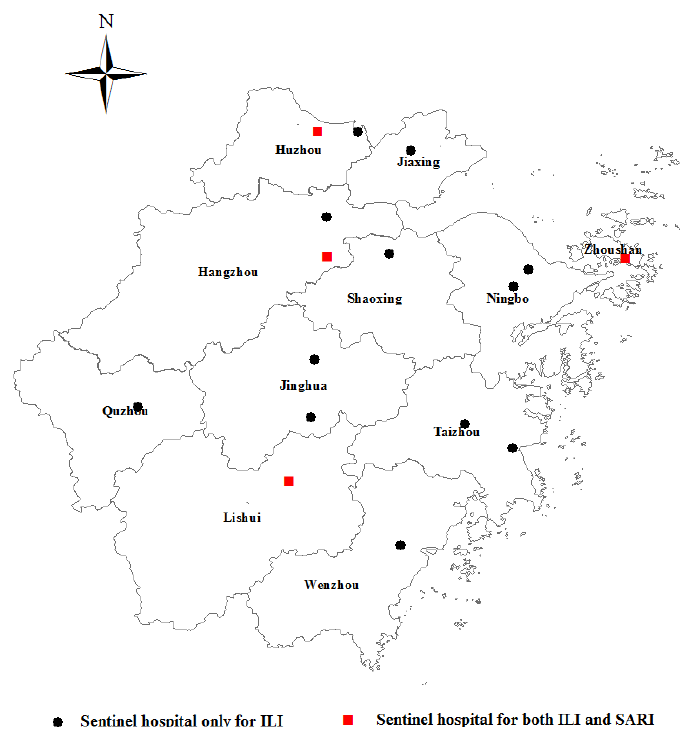
Figure 1. The geographical distribution of influenza sentinel hospitals in Zhejiang Province, China. (12 sentinel hospitals only for ILI, four sentinel hospitals for both ILI and SARI. ILI = Influenza-like illness; SAIR = severe acute respiratory illness).